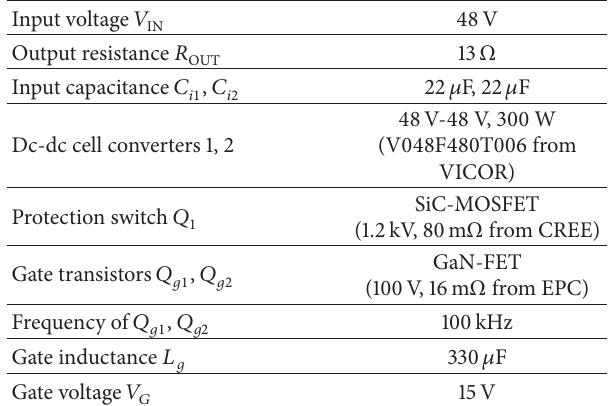
Table 1: Parameters for active gate control